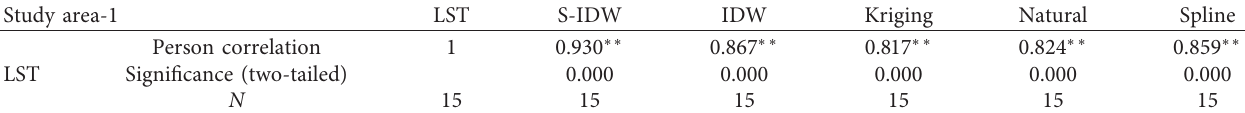
∗∗ Significant correlation at 0.01 level (two-tailed).